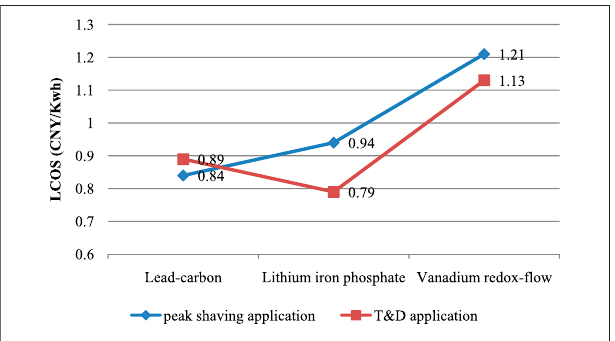
FIGURE 10 | Sensitivity analysis of the round-trip ef fi ciency to the LCOS of EES.